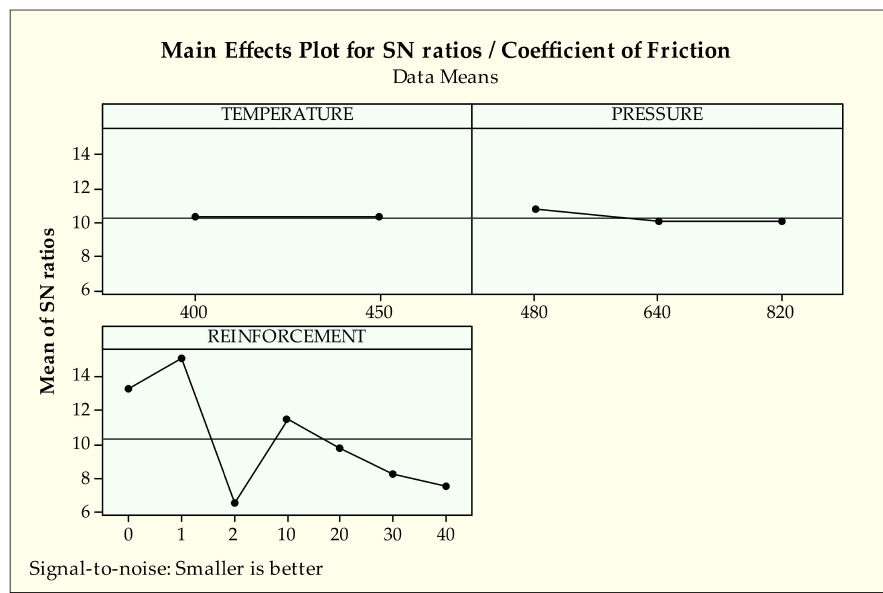
Figure 9. S/N ratios of coefficient of